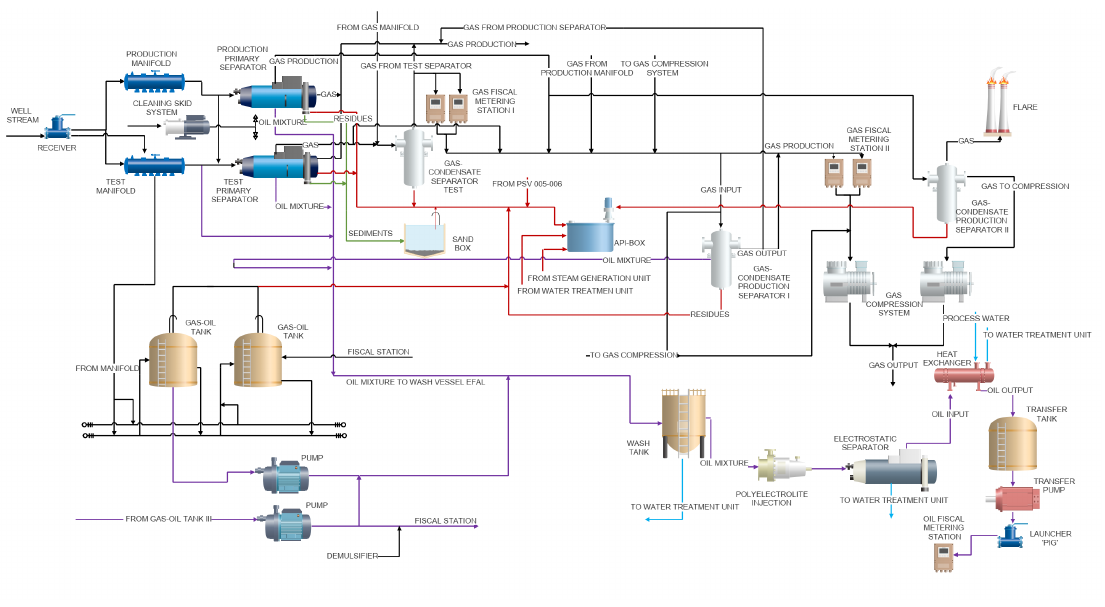
Figure 2. Oil and gas metering station